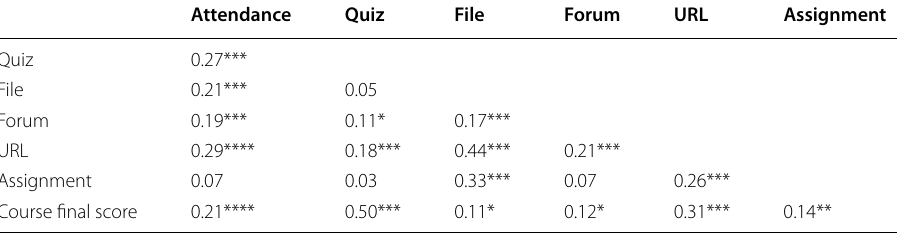
Quiz Formative assessment performance